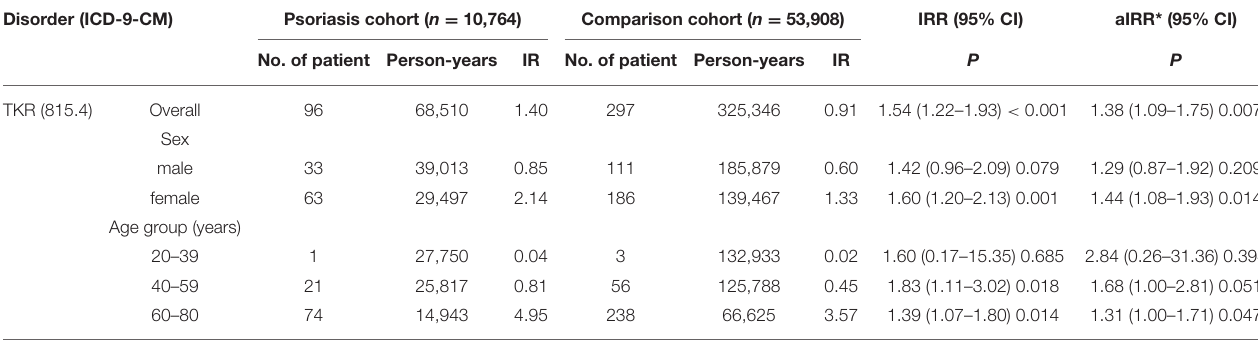
TABLE 2 | The incidence rate and incidence risk ratio of total knee replacement in the psoriasis cohort and comparison cohort ( N = 64,672). Disorder